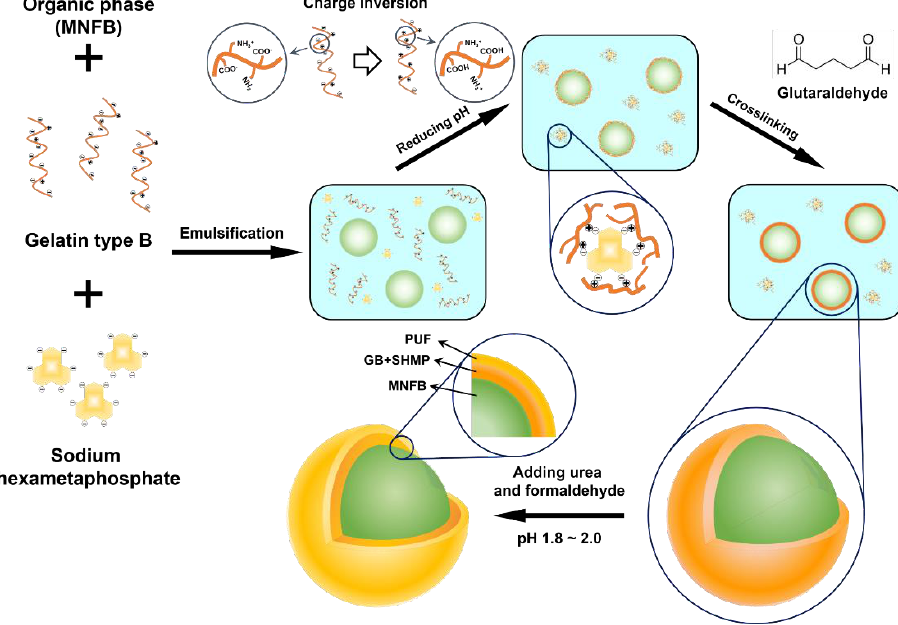
Figure 1. Schematic illustration of the DL-MC microencapsulation process.